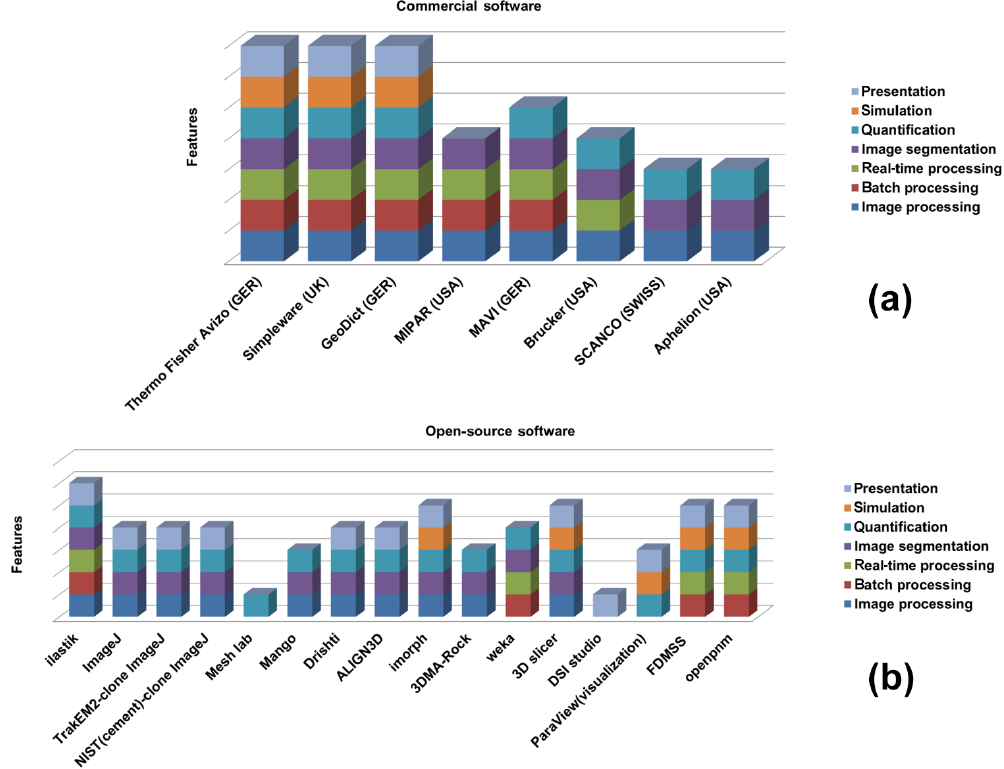
Figure 1. Market survey of the currently available commercial software (a) and open-source software (b) assisting in digital rock physics analysis with features as indicated in the